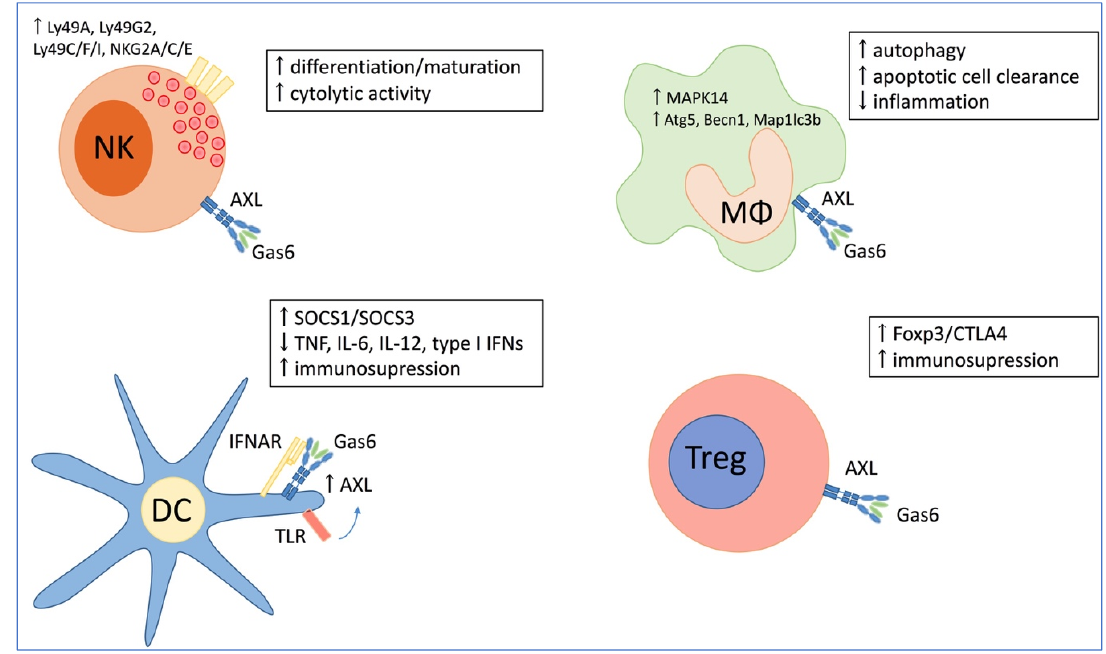
Figure 1. Schematic overview of GAS6/AXL expression in normal immunological cells including natural killer (NK) cells, dendritic cells (DC), regulatory T cells (Treg), and macrophages (MΦ). GAS6/AXL interaction regulates normal NK cell development, maturation and cytolytic activity. Binding of GAS6 to AXL increases the immunosuppressive capacity of DC and Treg. In macrophages, GAS6/AXL signaling induces autophagy, decreases inflammation, and regulates apoptotic cell clearance. Gas6 = growth arrest-specific protein 6